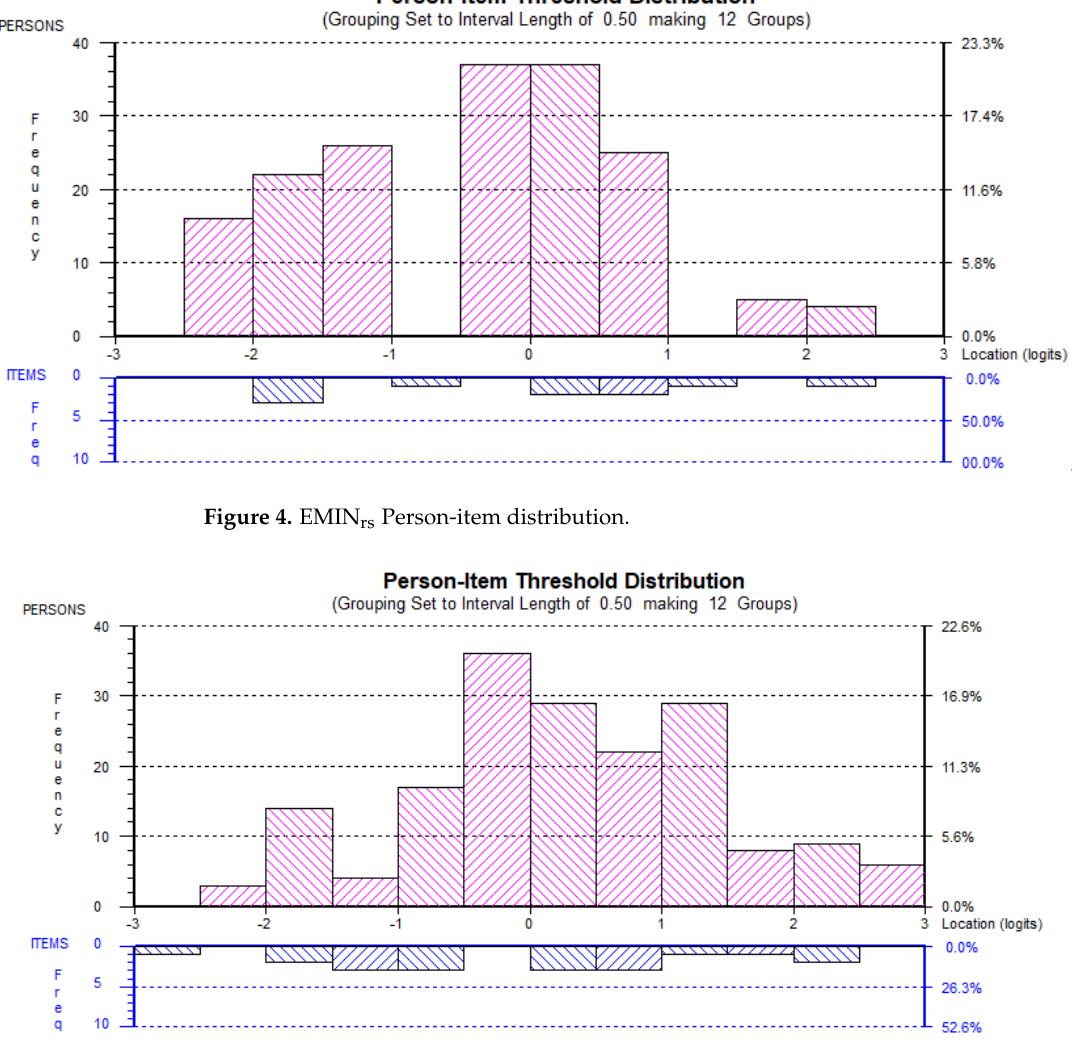
Figure 3. EMID rs Person-item distribution.